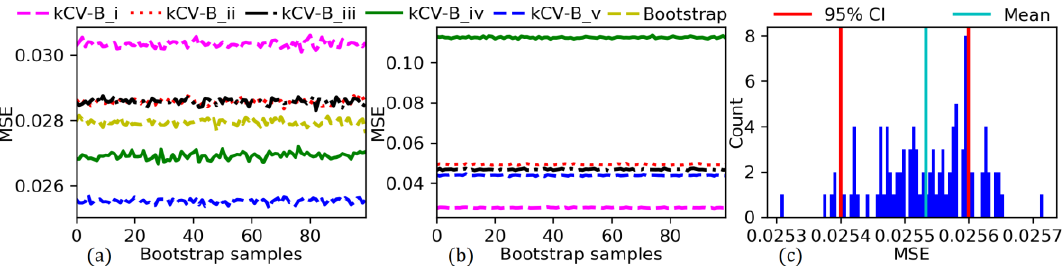
Figure 2. Exploration of the MSE values for the bootstrap samples from different folds and validation sets: (a) line diagrams for the shuffled data, (b) line diagrams for the unshuffled data, (c) histograms for the MSE values for the vth fold k CV-B v with 95% CI (red vertical line) and the mean (cyan vertical line).